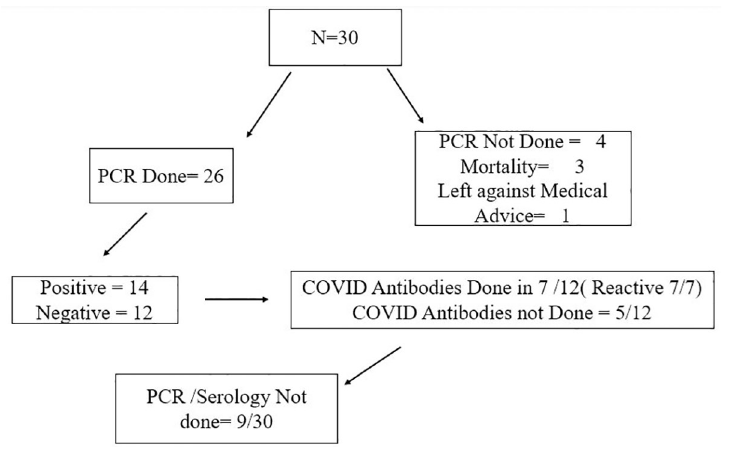
Fig 1. SARS CoV PCR and serology